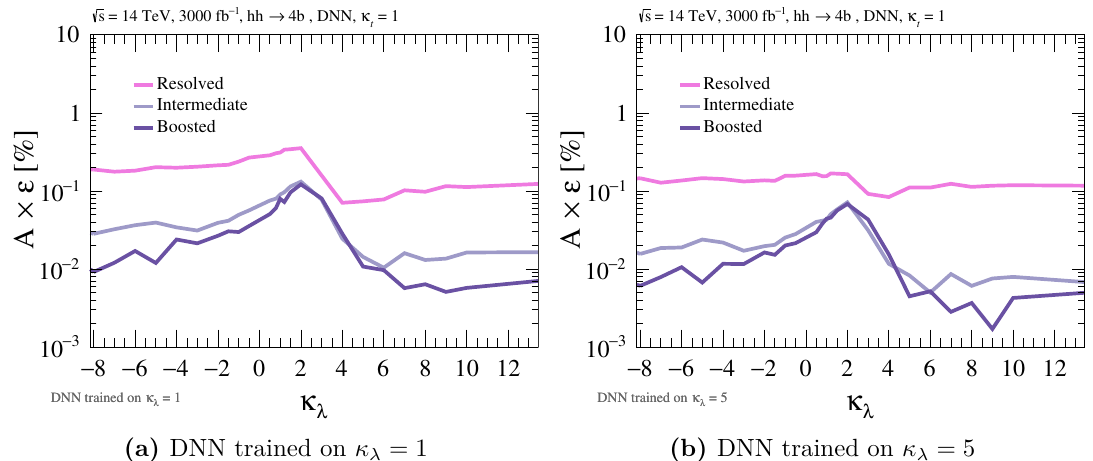
Figure 20. Signal acceptance times efficiency A × ε in percent for the neural network analysis trained on (a) κ λ = 1 and (b) κ λ = 5 after the signal score requirement p DNN shown for the resolved (pink), intermediate (lilac) and boosted (purple) channels. The A × ε is equivalent to the number of signal events S divided by initial number of events σ × L